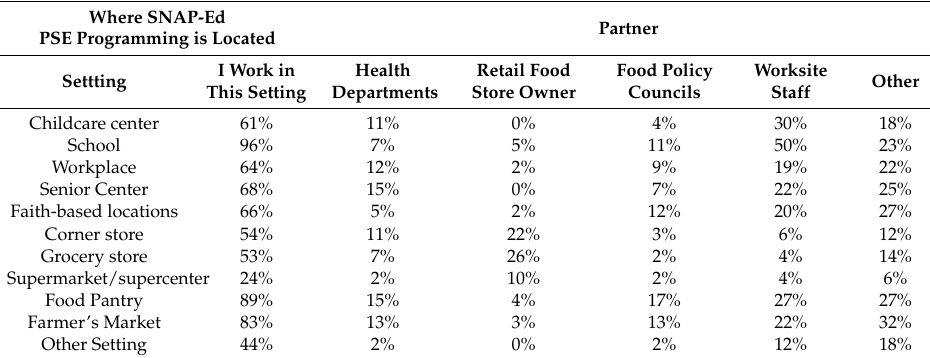
Table 1. PSE Settings and